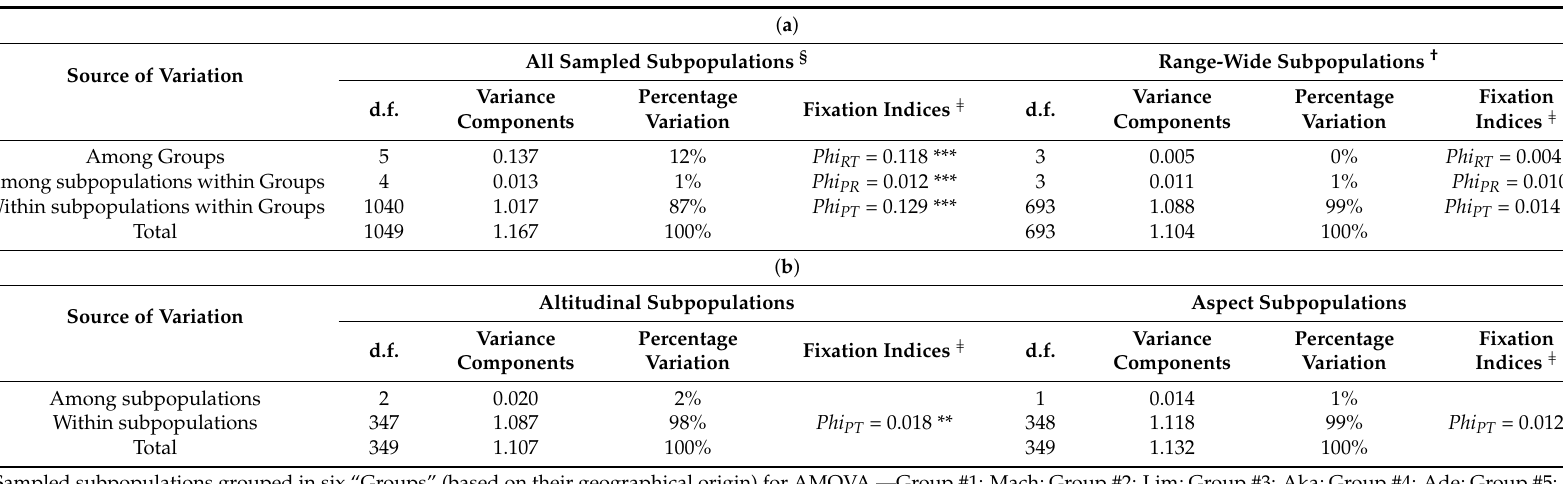
Table 3. Summary of the hierarchical analysis of molecular variance (AMOVA). ( a ) Hierarchical AMOVA based on the sampled subpopulation patterns, (i) all sampled subpopulations and (ii) range-wide subpopulations. ( b ) Hierarchical AMOVA based on marginality level, (i) altitude gradient subpopulations and (ii) different orientation